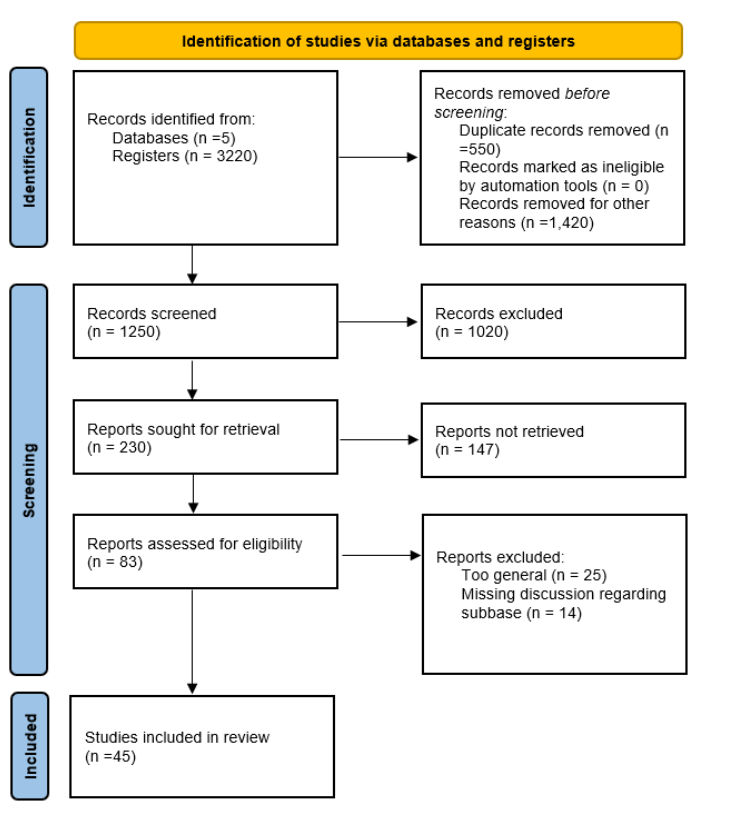
Figure 1. PRISMA flow diagram for the systematic review in this literature review.